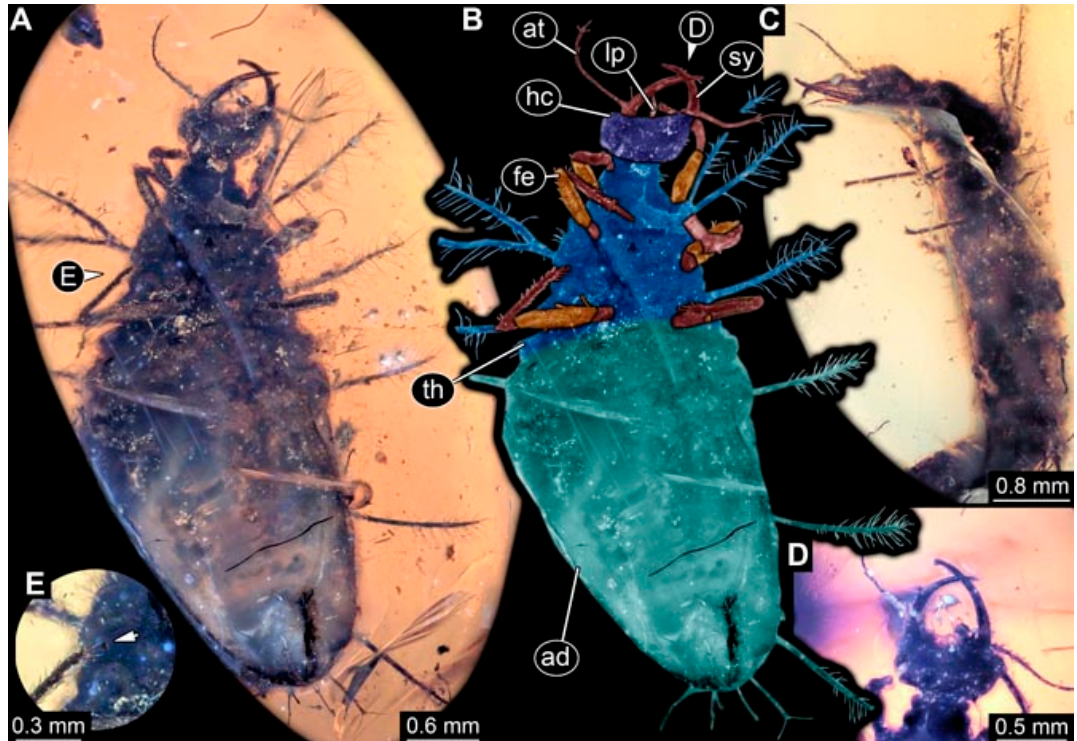
Figure 44. Specimen 4874 (PED 1333); Myanmar amber. ( A ) Ventral view. ( B ) Ventral view, colour- marked. ( C ) Lateral view. ( D ) Close-up of head capsule in ventral view. ( E ) Close-up of trunk appendage with empodium (arrow). Abbreviations: ad = abdomen; at = antenna; fe = femur; hc = head capsule; lp = labial palp; sy = stylet; th = thorax.